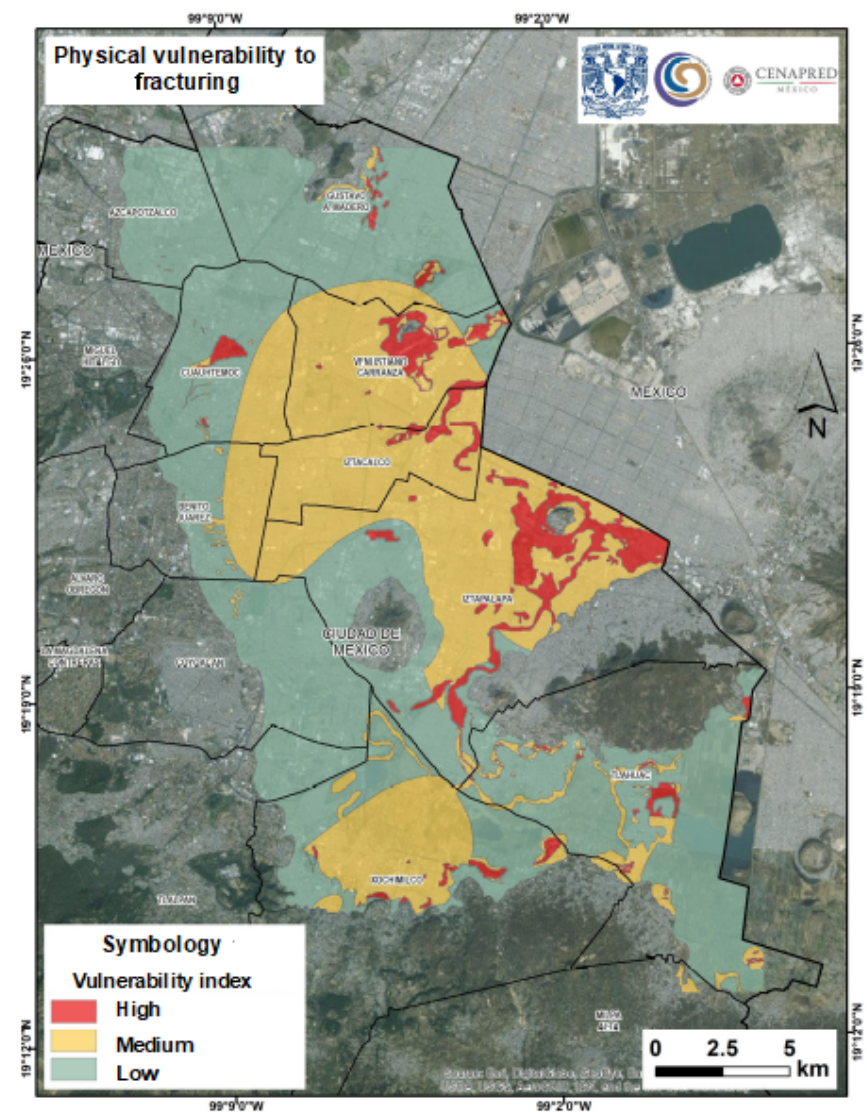
Figure 4. Mexico City distribution map of the physical vulnerability index to fracturing (Carreón Freyre et al.,